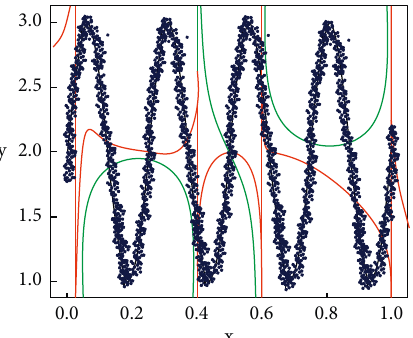
Figure 2: Overall trigonometric function